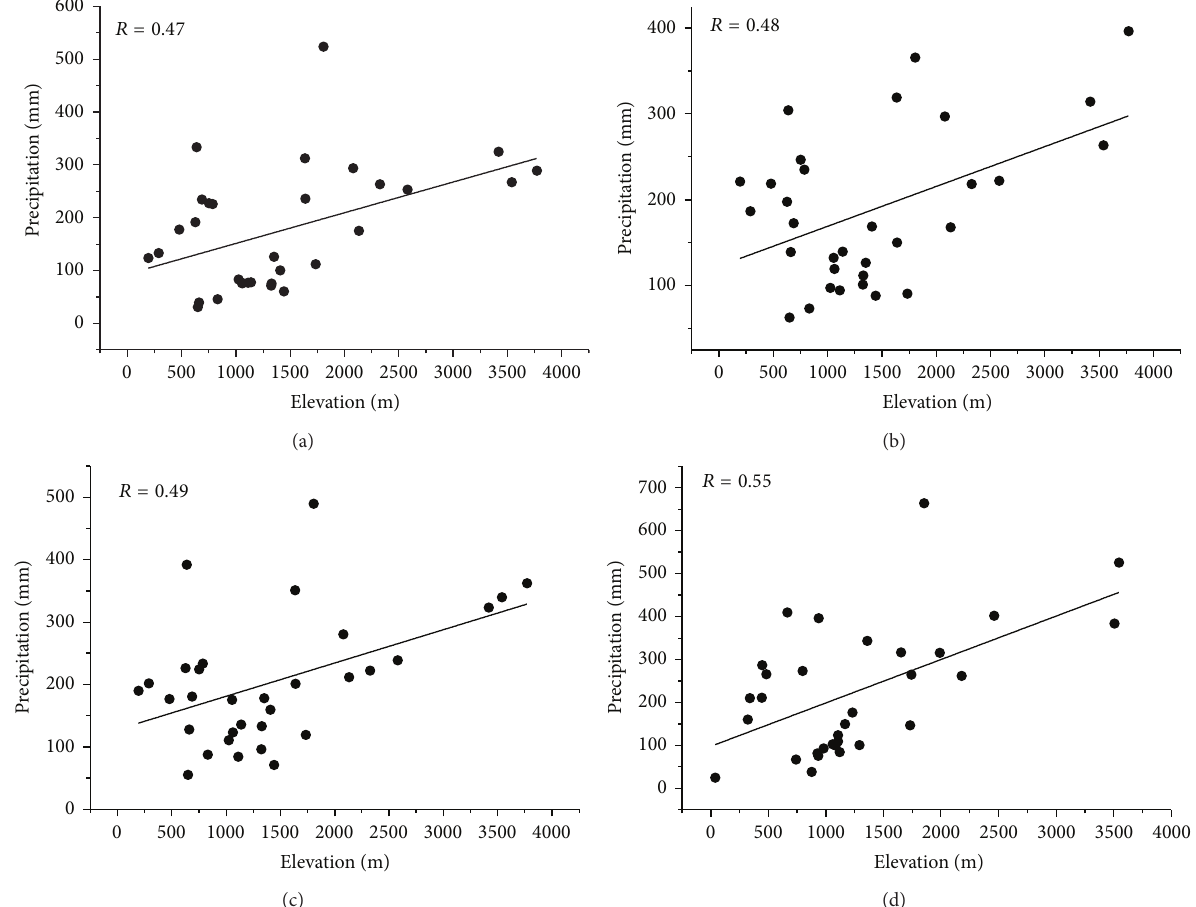
Figure 6: The correlation coefficient of annual mean precipitation and elevation. (a) Correlation coefficient of APHRODITE and elevation, (b) correlation coefficient of TRMM V6 and elevation, (c) correlation coefficient of TRMM V7 and elevation, and (d) correlation coefficient of rain gauge and elevation,